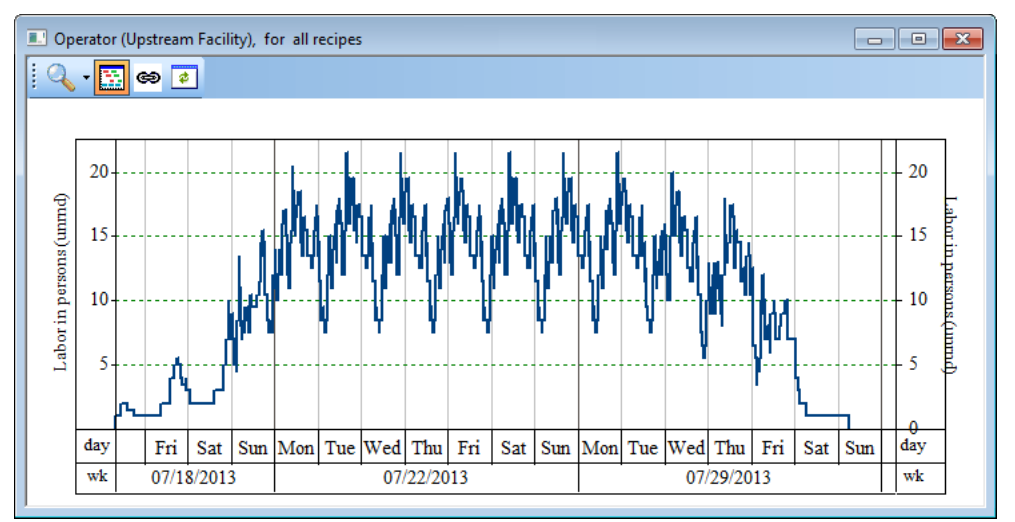
Figure 11. Operator labor demand for multiple